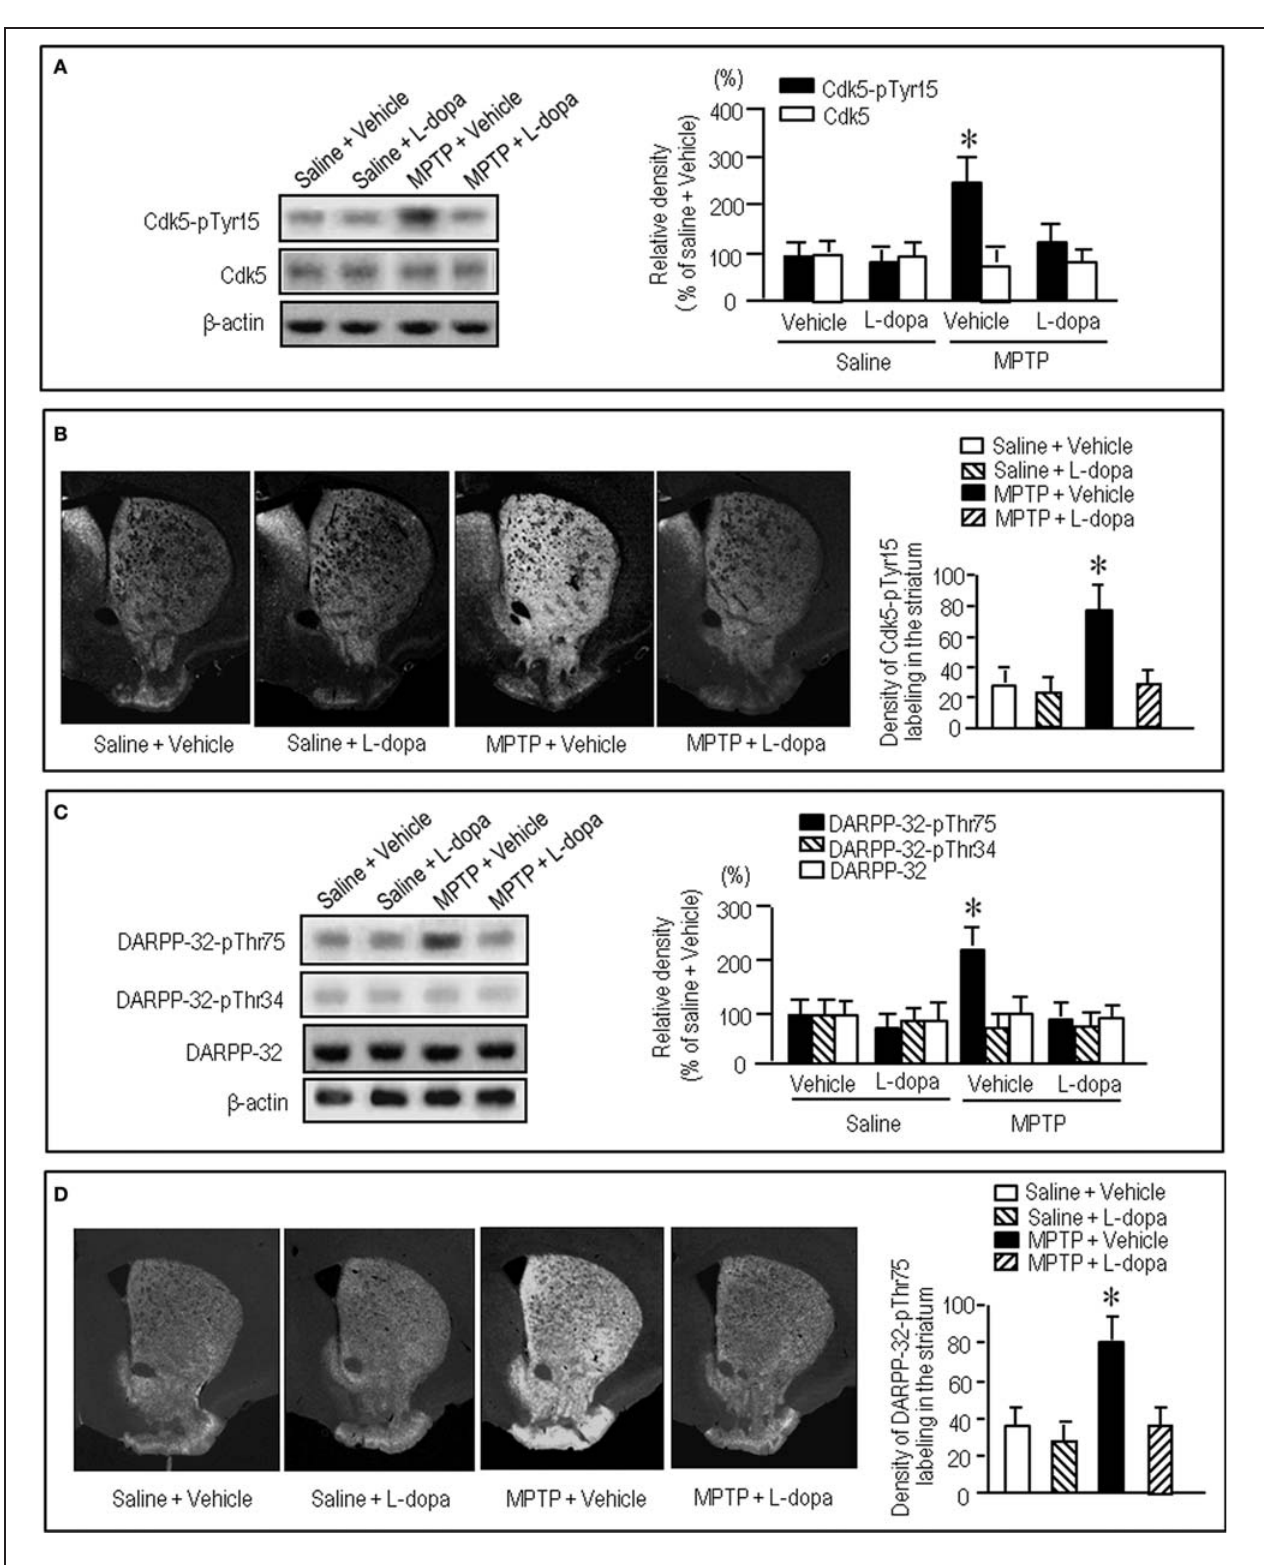
FIGURE 5 | Effects of L-dopa on striatal phosphorylation of Cdk5 and DARPP-32 in MPTP mice. Saline- or MPTP-treated mice received vehicle or L-dopa 30min before sacrifice. Striatal tissue extracts and sections